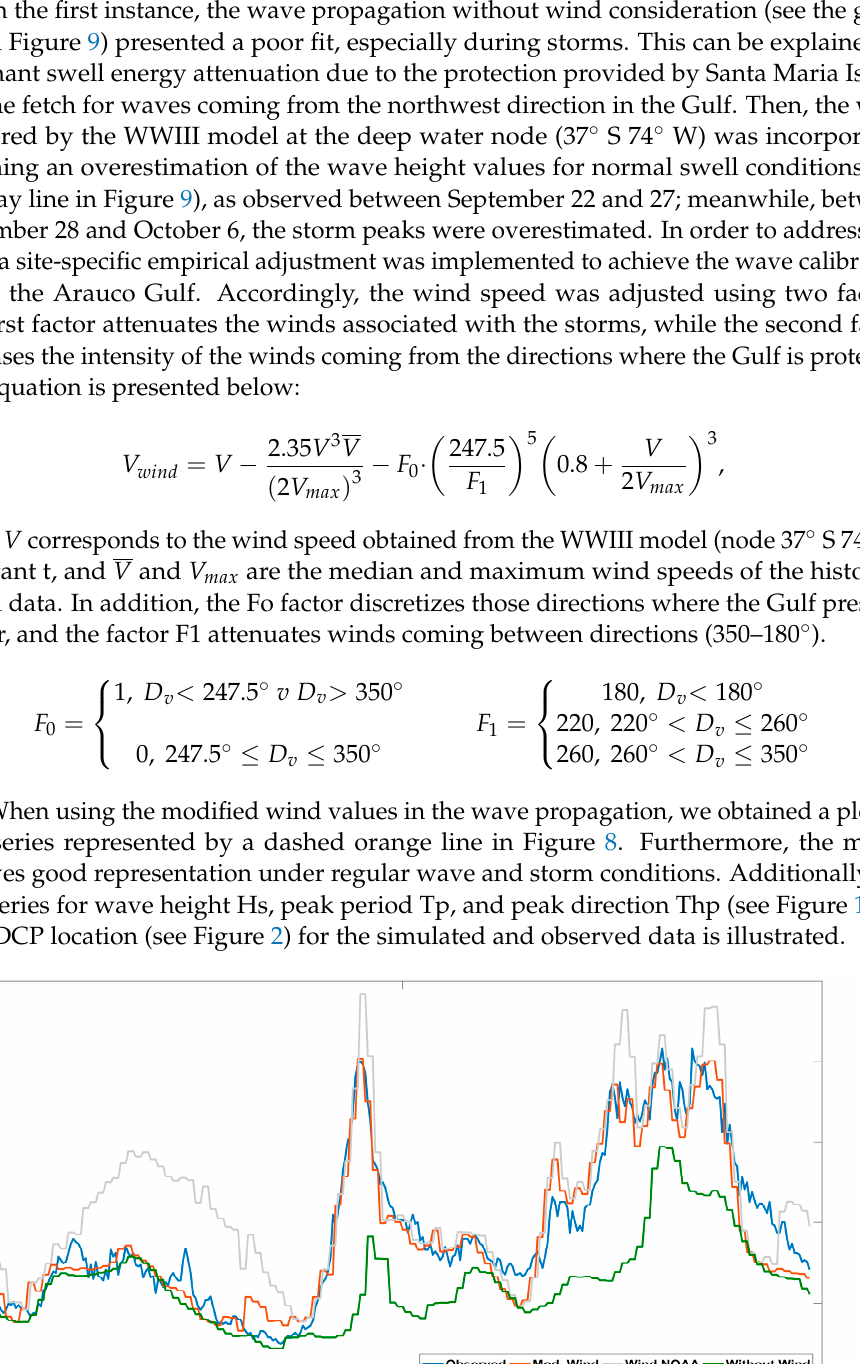
Figure 10. Wave data time series measured with ADCP (blue solid line) and simulated data (orange dashed line). 4.4. MOR Calibration Figure 11 shows the observed and simulated transverse profiles of the Escuadrón and Tubul beaches. In Escuadrón, an accretion profile is observed under the prevailing wave conditions between March 2011 and April 2011. Meanwhile, using a storm that occurred between March 2012 and May 2012 as a forcing agent, an erosional profile is generated for Tubul beach. In the case of Escuadrón, it can be seen that the profile adjusts well in the upper zone, although in the lower zone, there are differences. In Tubul, the transverse profile observed in May 2012 shows a break due to the erosion generated by the storm, although the simulated profile does not manage to generate this discontinuity. The differ- ences between the observed and simulated profiles arise from the model’s simplification. The forcing wave data used during the simulation were constant over time, and not